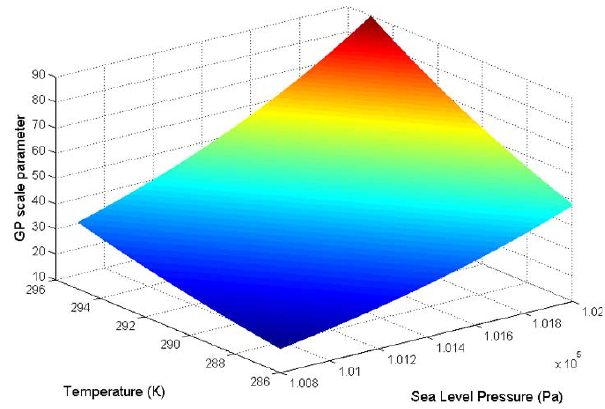
Fig. 4. Relationship between the number of heavy rainfall events and the frequency of WP4 in fall.